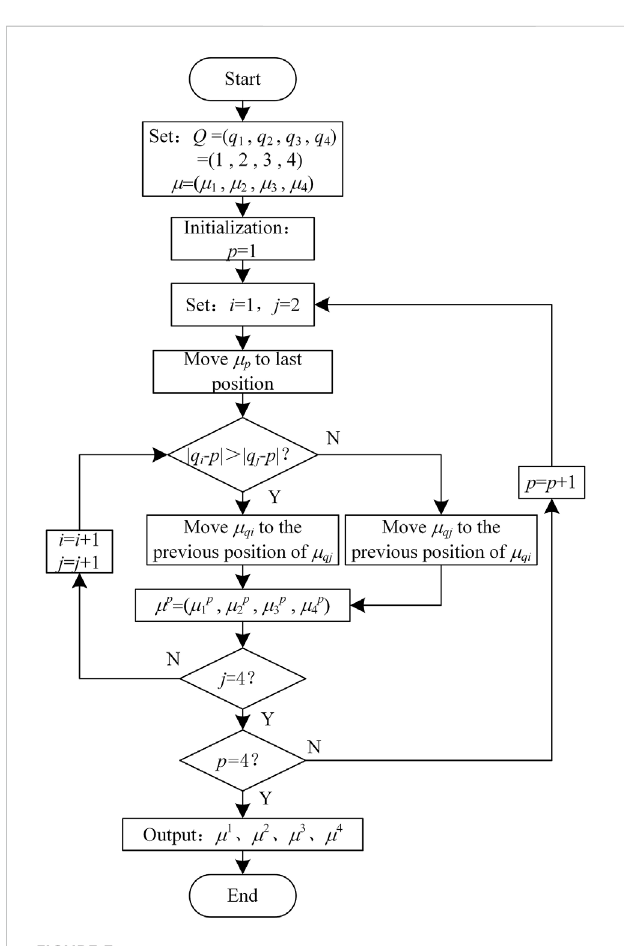
FIGURE 3 Standardization process of membership degree of target